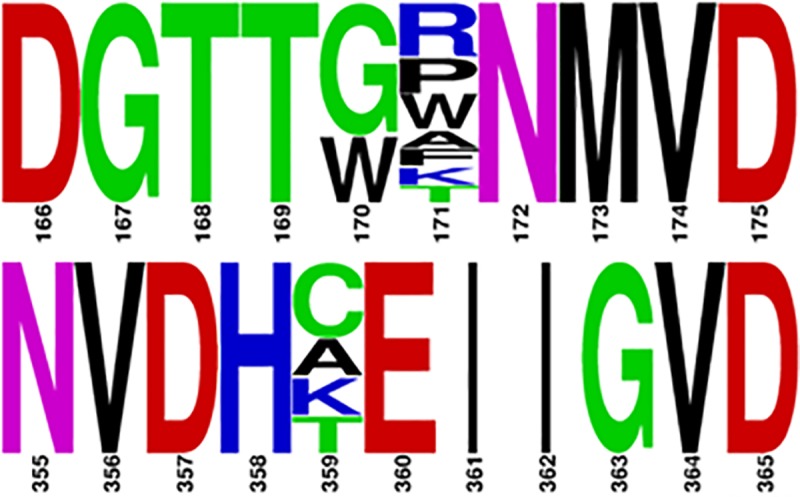
Mutations at different positions which showed improved differential activity during screening.Occurrences of GTL amino acids at the positions of mutation are ignored for better presentation. The figure and the colour code is generated by WebLogo [52].